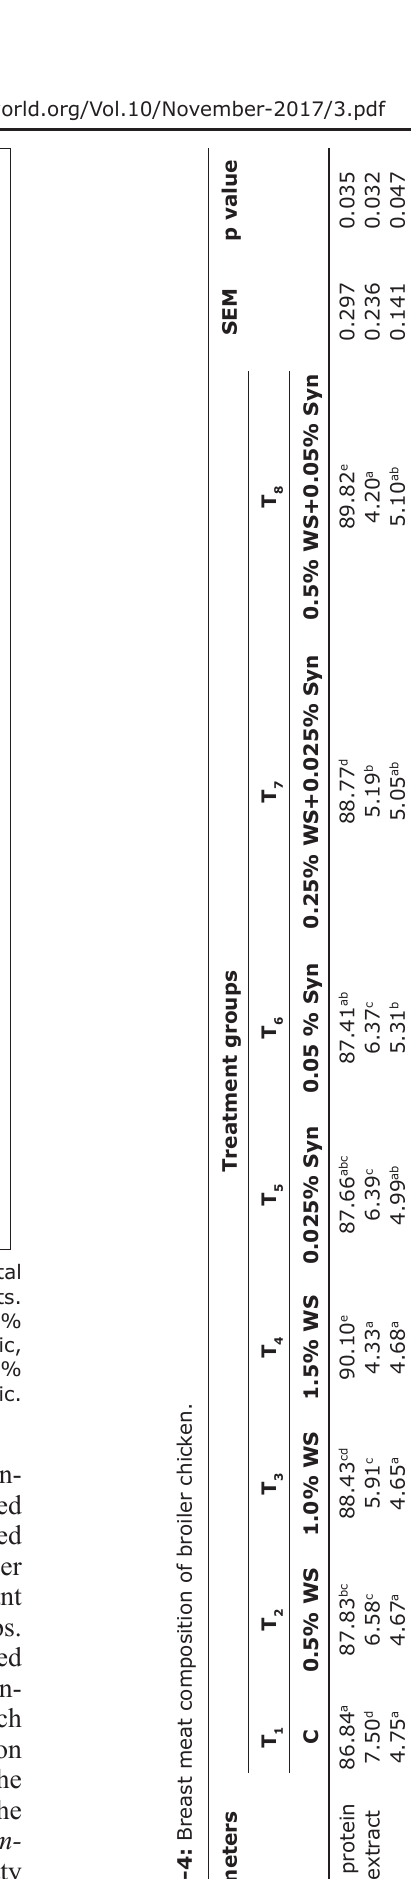
: 0.5% Withania somnifera , T 2 : 1.5% W. somnifera , T 4